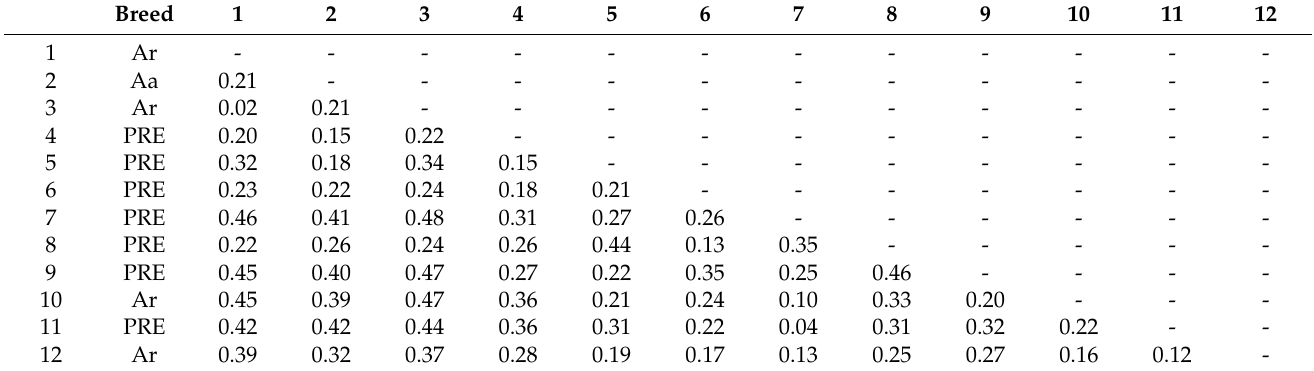
Table 2. Bray-Curtis dissimilarity. Values closer to 1.00 mean more dissimilarity between samples. Numbers represent animals. PRE: Andalusian. Aa: Anglo-Arabian. Ar: Arabian. Values range from 0 to 1. Values closer to 1.00 mean more dissimilarity between